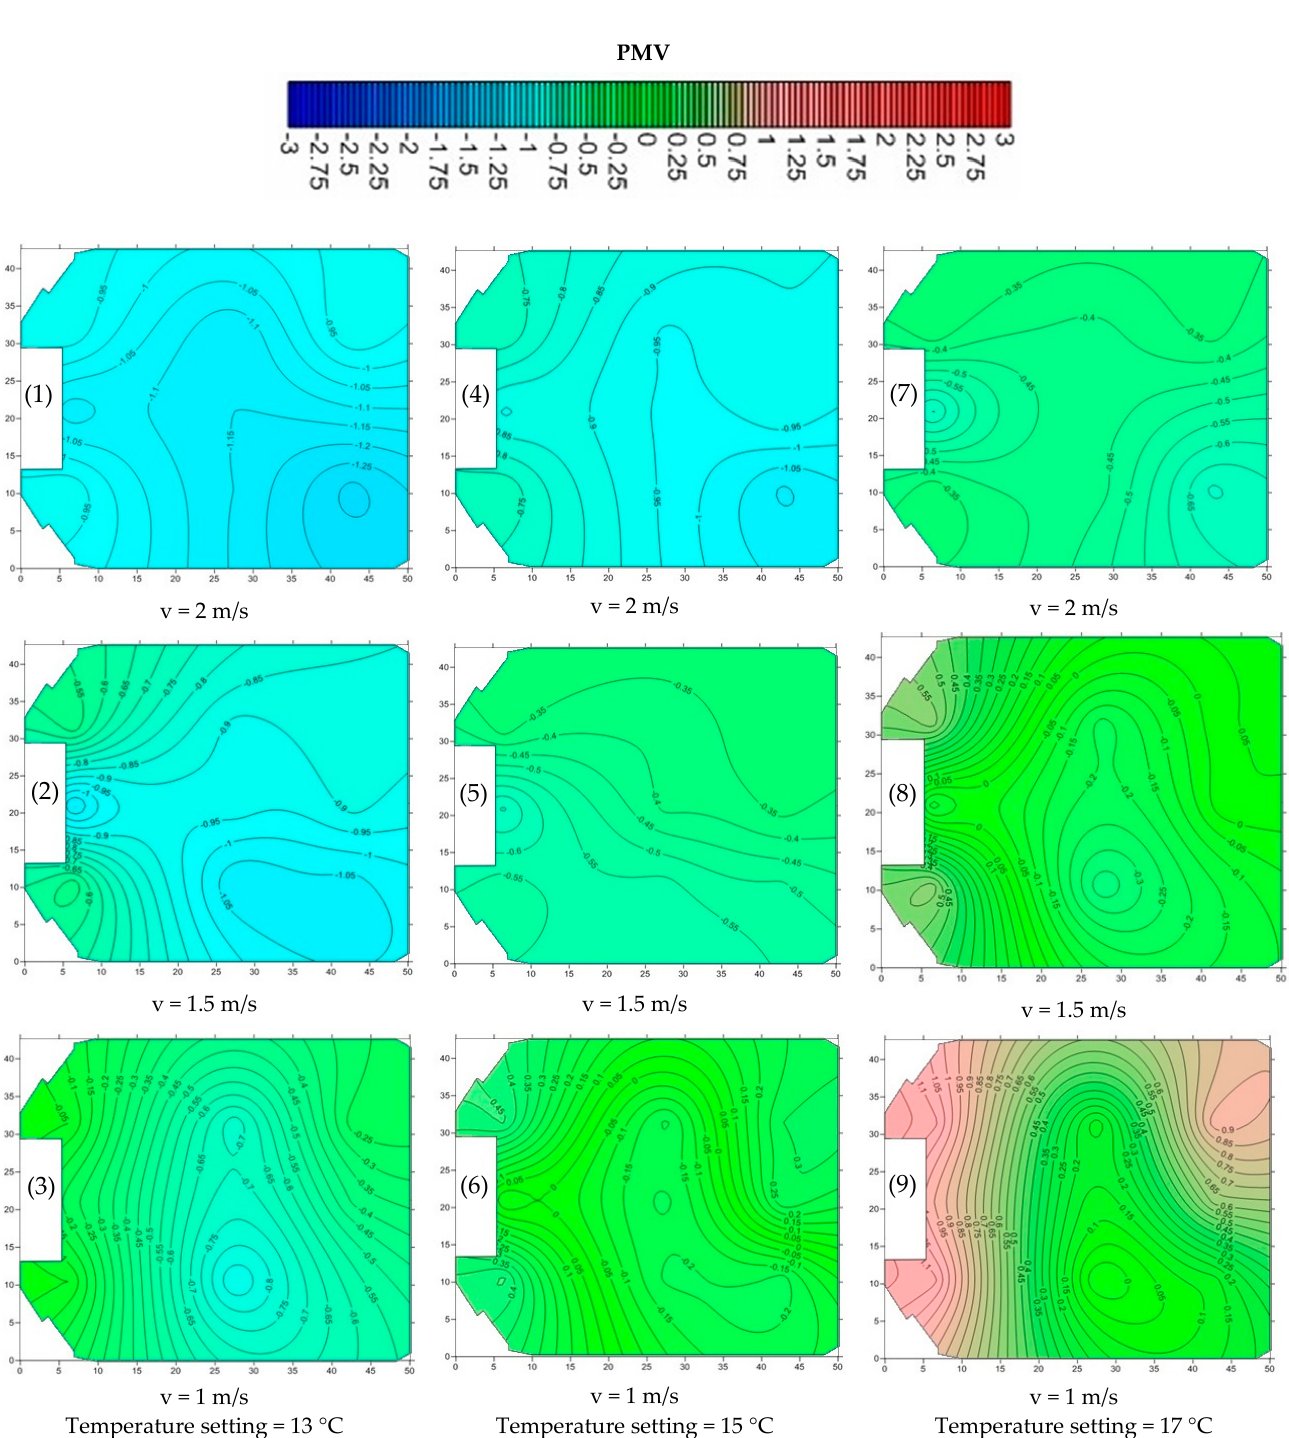
Figure 6. Thermal comfort distribution results in different temperature and air velocity settings. The PMV level for the conference hall comfort was evaluated in different temperature and air velocity settings. Figure 7a shows the PMV of the sampling points is less than − 1 (slight cool) under different supply air temperatures at 15 °C and 17 °C, except for the temperature setting at 13 °C, which has six sampling points larger than − 1 (slight cool) and is not acceptable on the PMV scale. In addition, Figure 7b presents the thermal comfort of the PMV of the supply air velocity at 1.5 m/s under different supply air temperatures. The results reveal that a PMV less than − 1 is concurs with different supply air temperatures at 15 °C and 17 °C, except with supply air temperatures at 13 °C in sampling